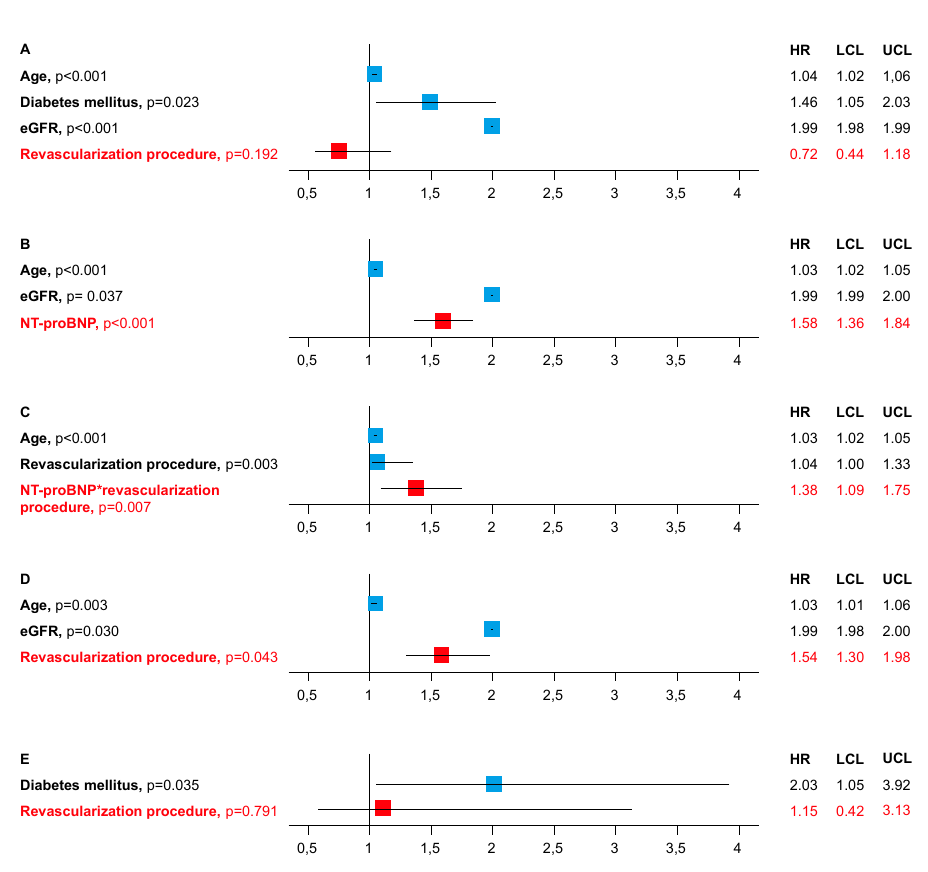
Figure 2. Predictors of death in Cox proportional hazards regression analyses. ( A ) The type of revascularization procedure was not an independent predictor of death in the entire study population. ( B ) NT-proBNP was the strongest independent predictor of death. ( C ) A significant interaction between NT-proBNP and the revascularization procedure: death was associated to the revascularization procedure, but only in those patients with elevated NT-proBNP levels. ( D ) Association between the type of revascularization procedure and death in patients with above median NT-proBNP. ( E ) No association between the type of revascularization procedure and death in patients with below median